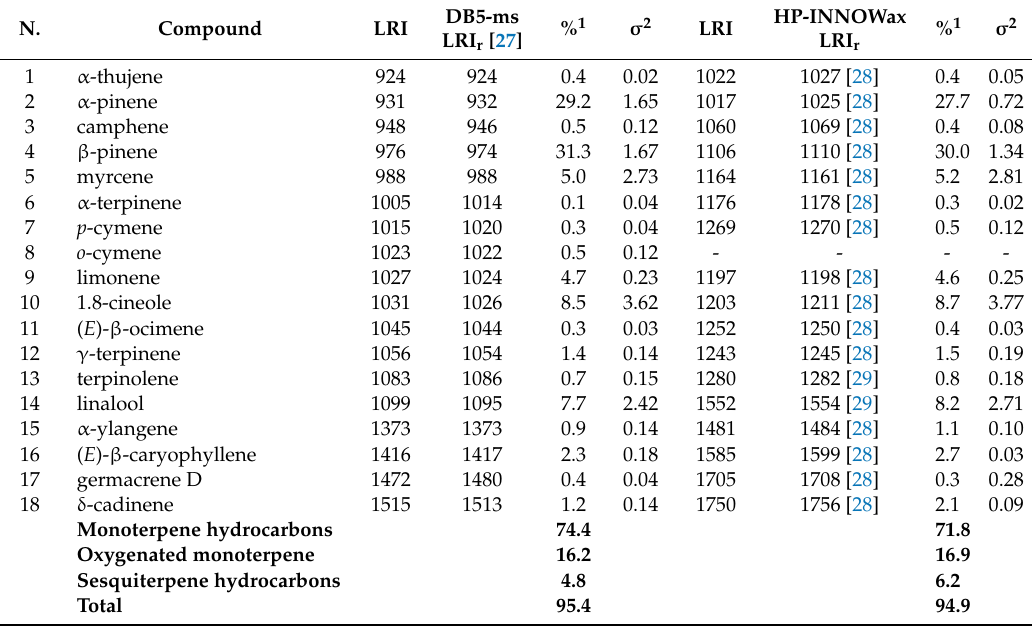
Table 2. Chemical composition of the essential oil of M. mollis in DB-5ms and HP-INNOWax columns.